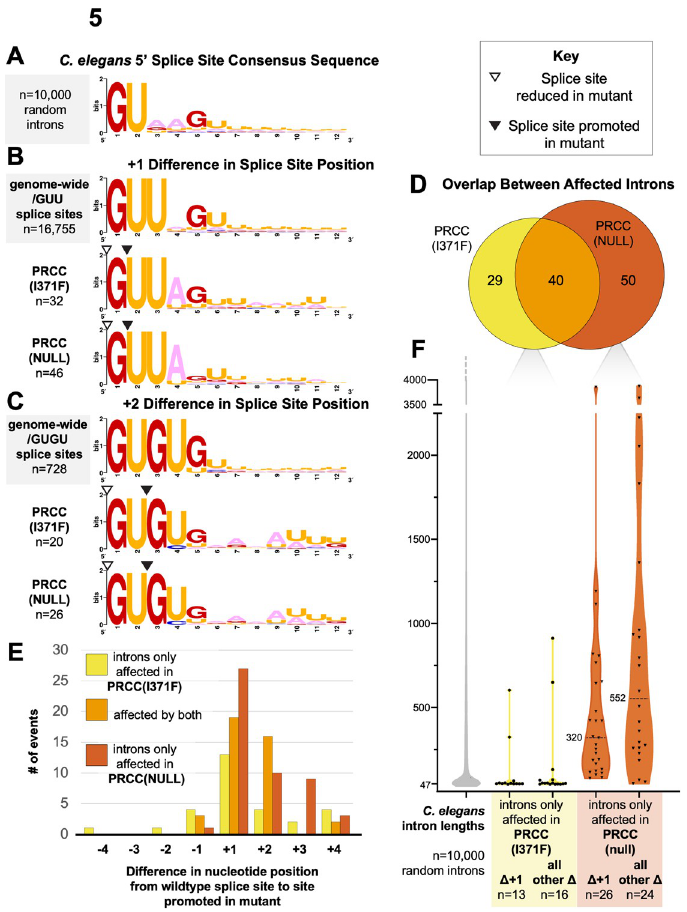
Fig 5. Throughout the genome, mutations in PRCC increase usage of /UU 5’ splice sites and /GU 5’ splice sites lacking other features. (A) Sequence logo showing the consensus sequence for the 5’ end of 10,000 randomly chosen C . elegans introns. (B) Sequence logo of introns that are differentially spliced in PRCC mutant backgrounds and follow the /G/UU splicing pattern seen in unc-73(e936) compared to all annotated introns that begin with /GUU. The splice site promoted in mutant is +1 nucleotides from the position of the predominant /GU splice site. Splice sites are indicated by triangles, as described in the key. (C) Sequence logo of introns that are differentially spliced in PRCC mutant backgrounds in which the splice site promoted in mutant is +2 nucleotides from the position of the predominant /GU splice site. Splice sites are indicated by triangles, as described in the key. (D) Euler diagram enumerating the overlap between affected introns differentially spliced in the presence of the two PRCC alleles. (E) Most splice sites promoted by the PRCC alleles are either one or two nucleotides downstream of the predominant splice site. Frequency and direction of nucleotide shift between the splice site favored in wild type, and the splice site promoted in PRCC mutant. (F) Violin plot showing the lengths of introns affected only in a given suppressors group. The five violins correspond to: 10,000 random wild-type C . elegans RefSeq introns, the subset of 13 introns in PRCC (I371F) in which the splice site promoted was at a /UU splice site 1 nucleotide downstream from the predominant splice site, the 16 affected introns in that same strain that did not follow +1 pattern, the subset of 26 introns in PRCC (null) in which the splice site promoted was at a /UU splice site 1 nucleotide downstream from the predominant splice site, the 24 affected introns in that same strain that did not follow +1 pattern. These groups of introns have median lengths of 47, 48, 51, 320, and 552 nucleotides,